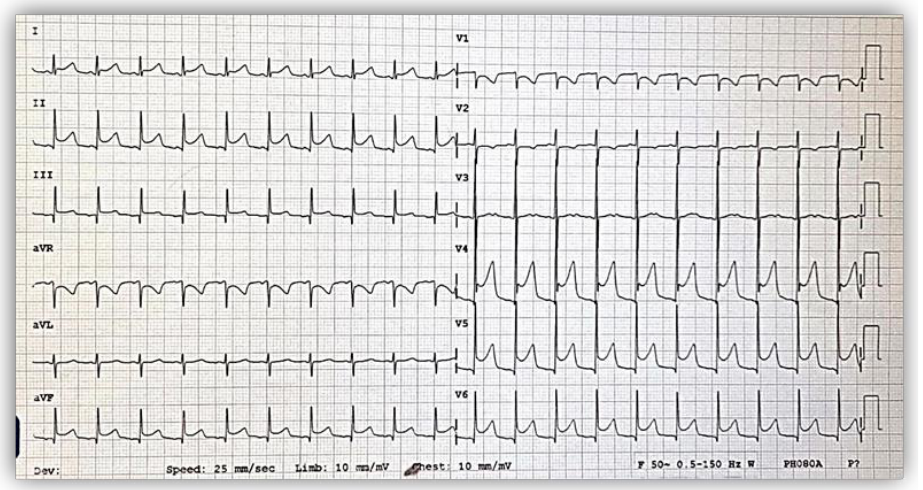
Figure 5. Postoperative electrocardiogram showing ST elevation in DII, DIII, aVF, and V4-V6 derivations, suggesting flow disturbance in the right coronary artery territory.